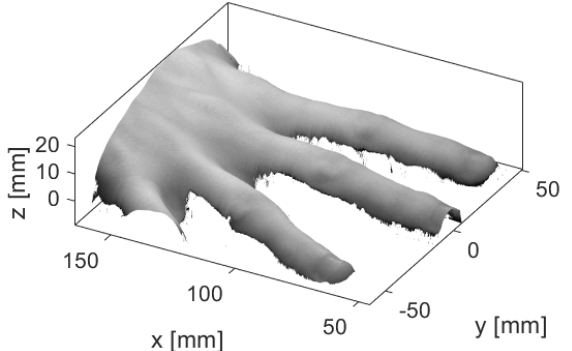
Figure 11. A 3D profile of a healthy human hand recorded using laser profilometry [19]. A spectral image recorded at 770 nm is overlaid over the 3D profile.